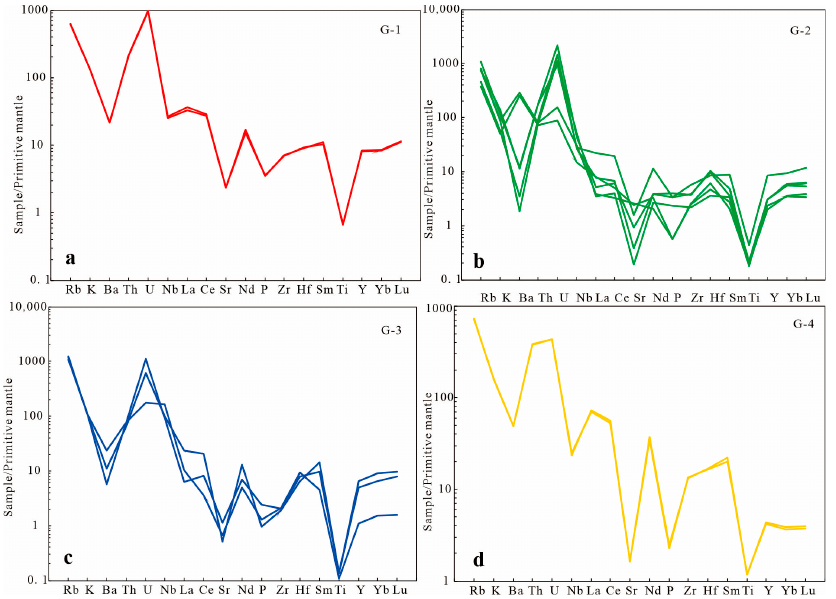
Figure 11. Primitivemantle-normalized trace element patterns of intrusions in Chuankou ore field (Standardized values from [48]). ( a ) G-1; ( b ) G-2; ( c ) G-3, ( d ) G-4. (Standardized values from [48]). ( a ) G-1; ( b ) G-2; ( c ) G-3, ( d )